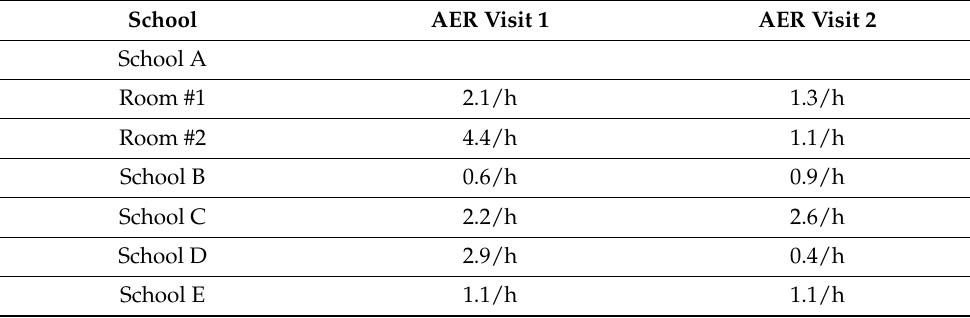
Table 5. Outdoor air exchange rate (AER